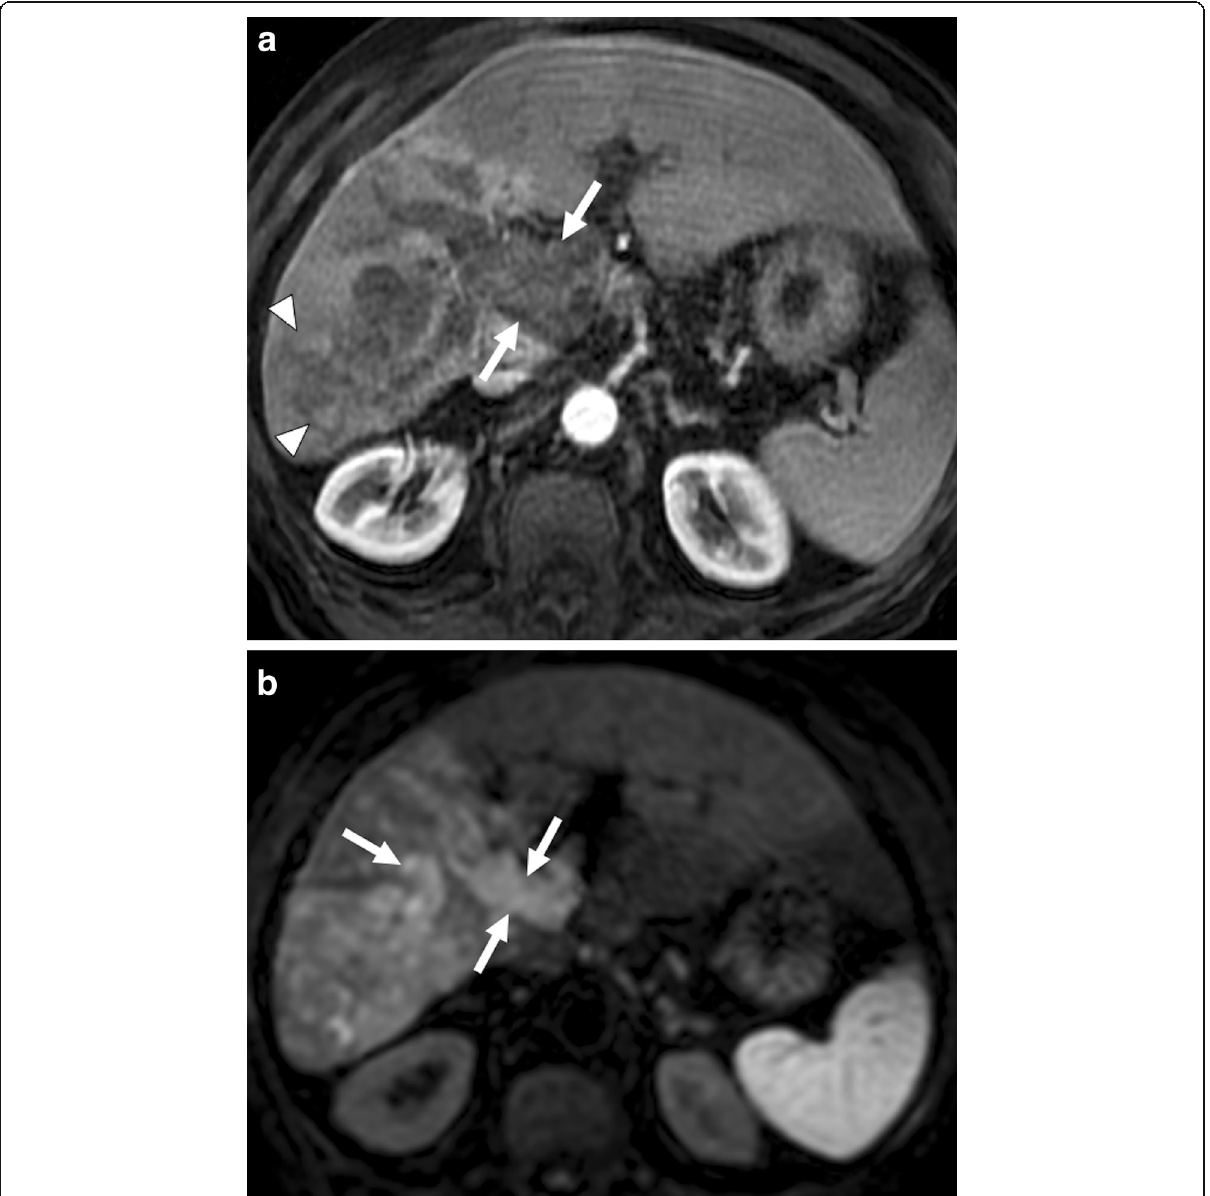
post-contrast arterial phase T1W MR image demonstrates HCC focus within the right liver lobe (arrowheads) with associating tumor within the main and right portal vein branches (arrows). Note contrast enhancement of the thrombus with extending outside the confines of the main portal vein. b DWI image shows high signal intensity representing diffusion restriction of the thrombus within the main portal vein